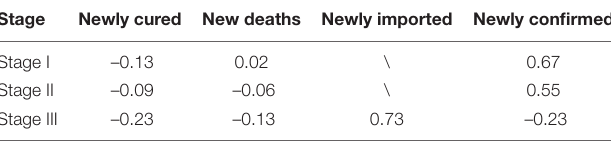
TABLE 5 | Correlation between epidemic indicators and the proportion of negative